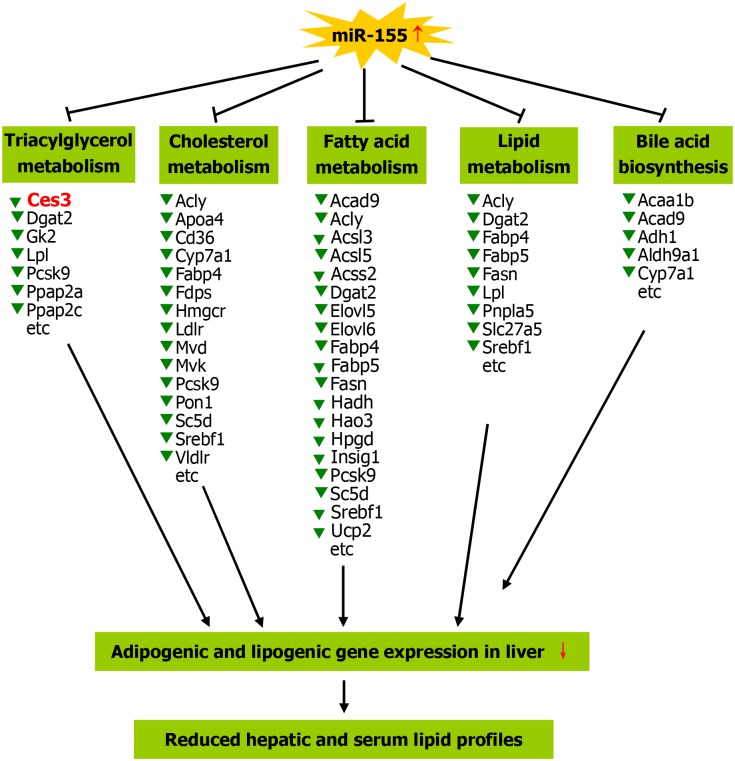
A proposed model on miR-155 overexpression reducing hepatic and blood lipid profiles.The enforced expression of miR-155 in the liver of transgenic mice is able to induce a general downward trend in the expression profile of hepatic genes involved lipogenesis, fatty acid metabolism, triacylglycerol metabolism, cholesterol metabolismn and bile acid biosynthesis, etc, thereby causing the decreased hepatic lipid content by decreasing adipogenic and lipogenic gene expression in liver, which reduces blood lipid concentration. Other details as in S6 Table and S7 Table.